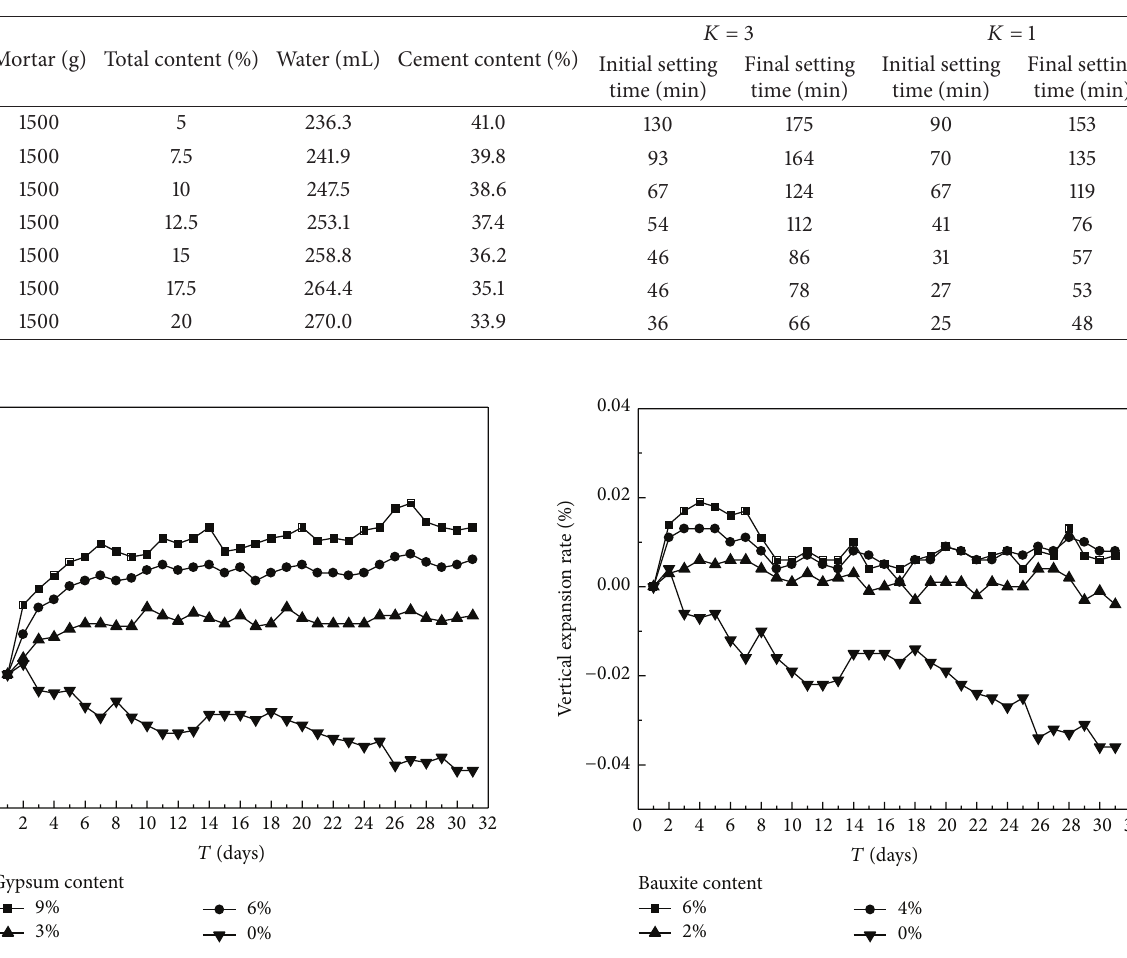
Table 7: Effect of mineral content and molar ratio 𝐾 on setting time of grouting mortar.